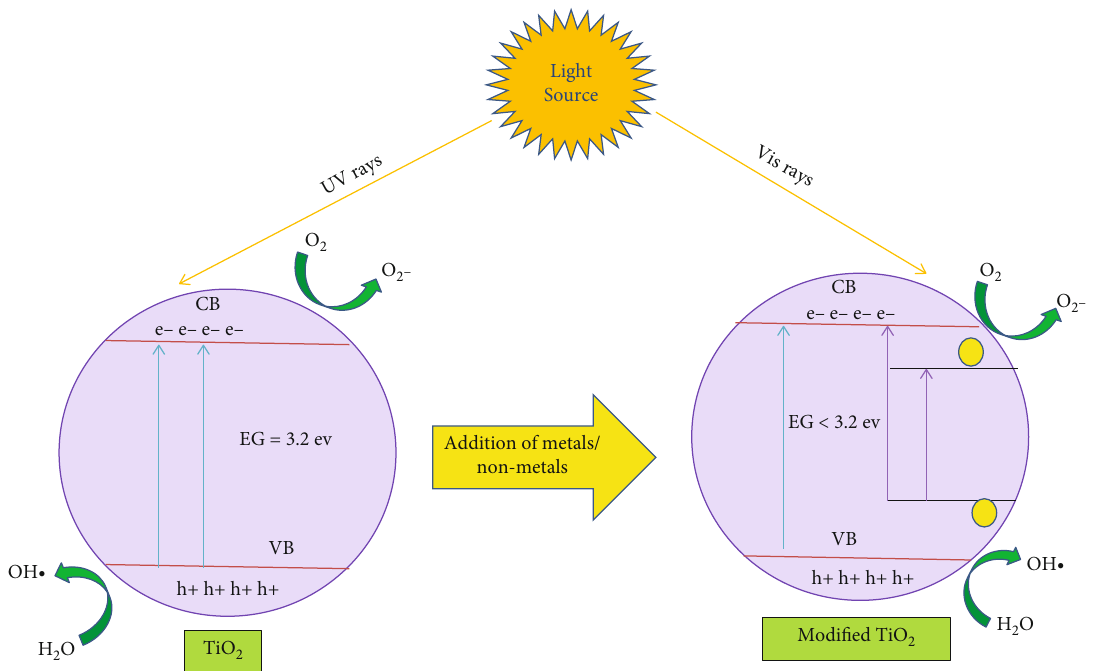
Figure 5: Photocatalytic activity of TiO